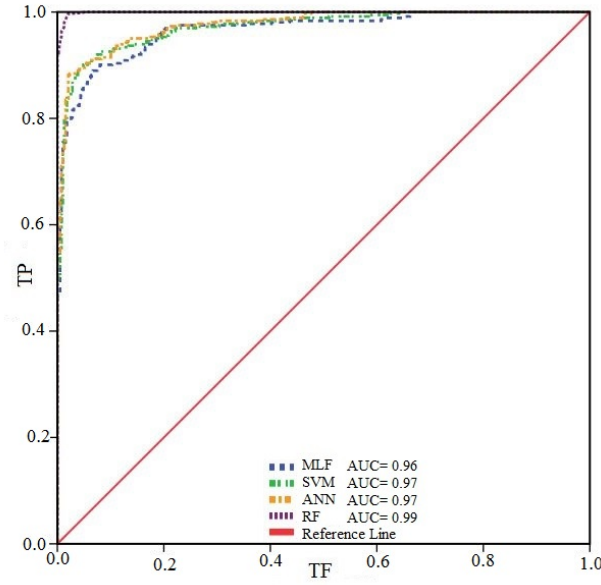
Figure 8. ROC/AUC for AI models.